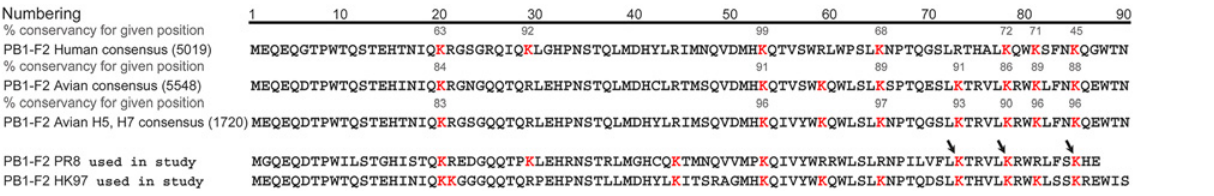
Fig 1. Comparison of the consensus sequences of PB1-F2 of Human, Avian, H5, H7 origin and sequences of PR8-, HK97- and 1918-derived PB1-F2. The consensus sequences of PB1-F2 from different species and the sequences of PB1-F2 from the model laboratory strains PR8 and HK97 were aligned, and all K residues are indicated in red to visualize differences in the potential ubiquitination sites. The numbers in brackets represent the amount of sequences used for consensus sequence generation. The numbers above the K residue represent the percentage of conservancy of the K residue for a given position in a set of analyzed sequences. The cluster of K residues is present in the C-terminal part of the molecule for human- and avian-derived